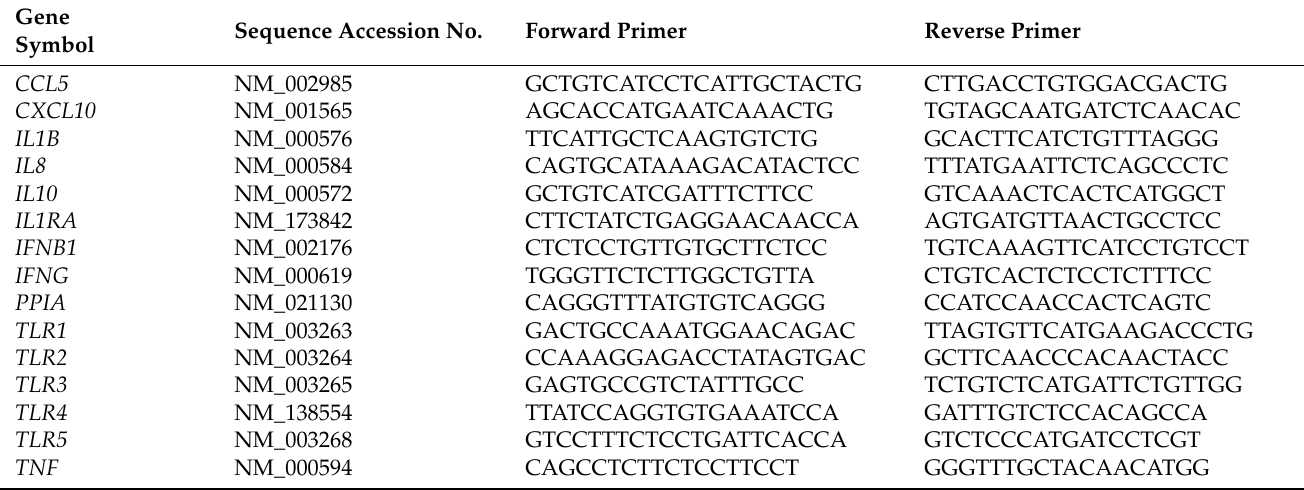
Table 3. List of primer sequences used for